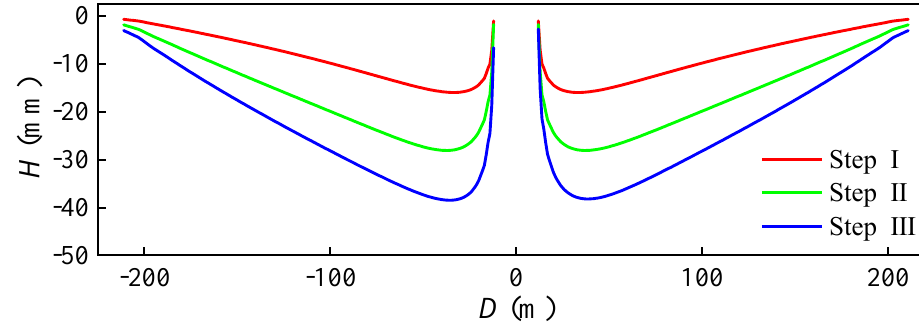
Table 5. The results of the orthogonal tests.